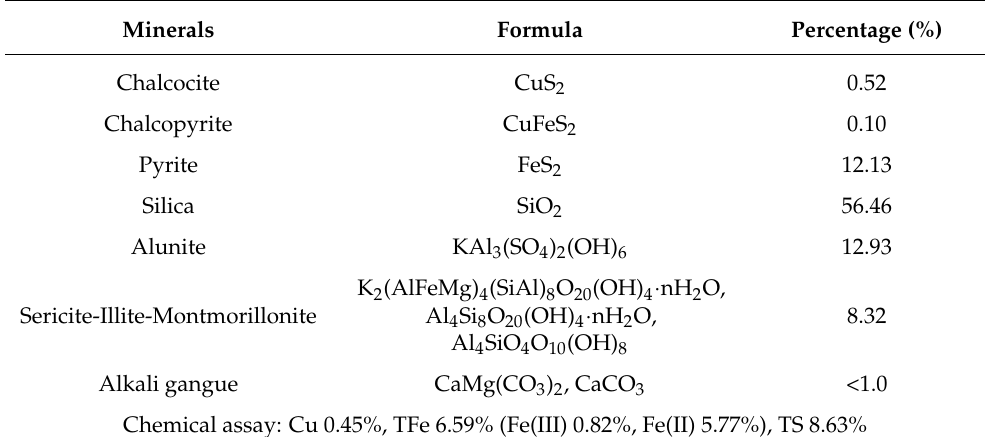
Table 1. Mineral composition of Letpadaung ore by Mineral Liberation Analyzer